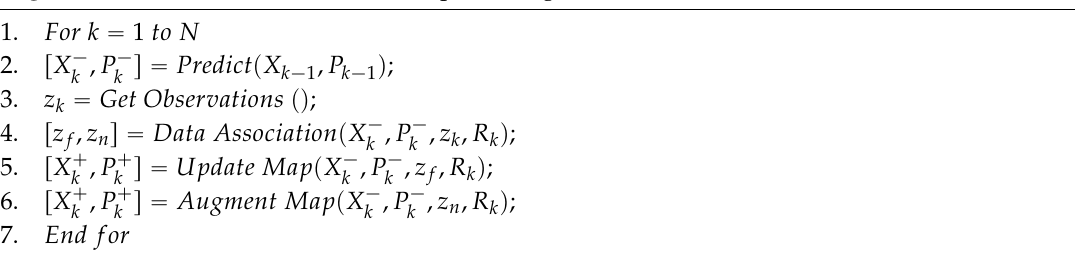
Algorithm 3 : Underwater landmark map building based on AEKF-SLAM